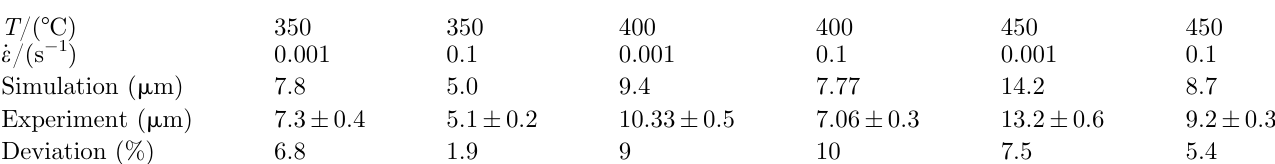
Table 1. Average grain size of simulation and experimental results under true strain e = 0.7. T /( ° C)